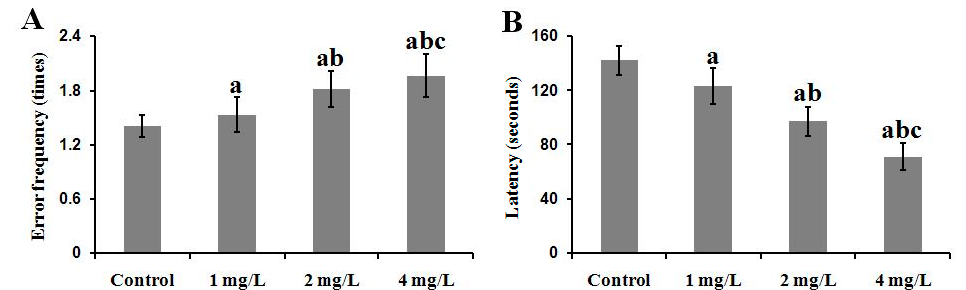
Figure 3. Effect of As exposure on state-dependent learning and memory abilities of mice. Adult male mice exposed to 0, 1, 2, and 4 mg/L As 2 O 3 in drinking water for 60 days. After the treatment, the step-down passive avoidance task was performed to analyze the state-dependent learning and memory abilities of mice. Data obtained from twelve separate analyses are expressed as mean ± SD n = 12 for each group). ( A ) Error frequency of step-down (times); ( B ) Latency to descend from the platform (seconds ). a p < 0.05 significantly different compared with the control group; b p < 0.05, significantly different compared with the 1 mg/L As 2 O 3 -treated group; c p < 0.05 significantly different compared with the 2 mg/L As 2 O 3 -treated group.